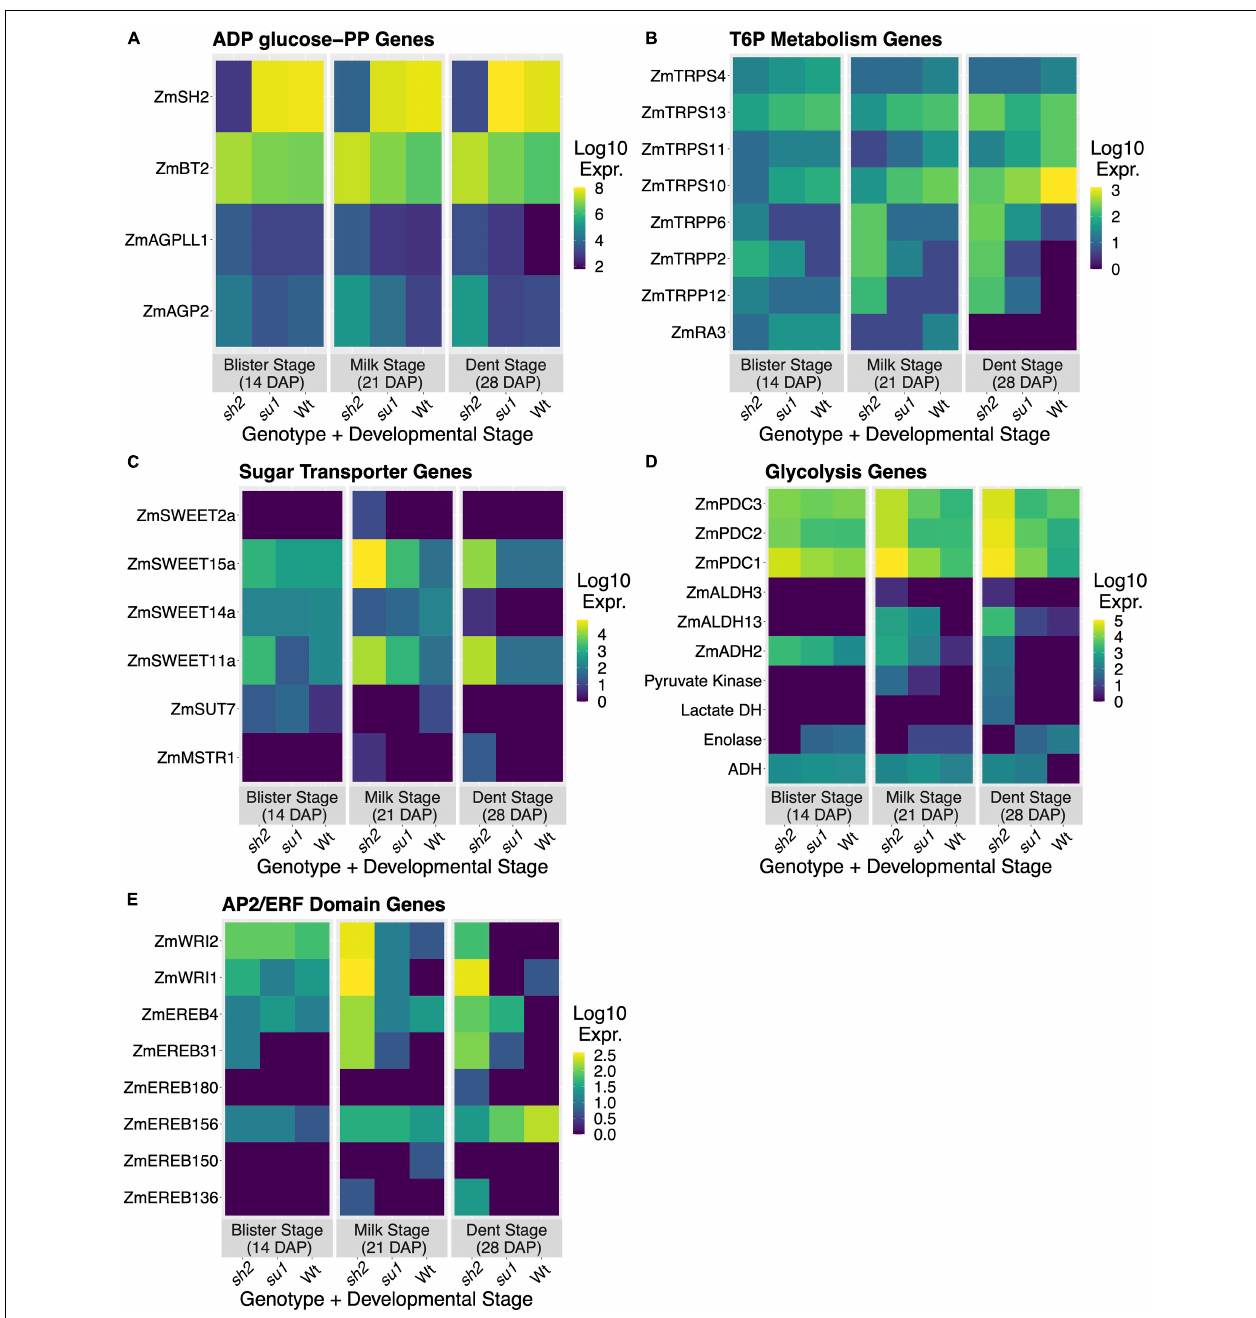
FIGURE 4 | Differential expression in maize endosperm. Relative expression levels of DEGs in each mutant/timepoint combination. Values shown represent the log 10 of the TPM summed across transcripts and averaged across backgrounds. (A) Relative expression of AGPase-encoding genes. (B) Relative expression of trehalose-6-phosphate metabolizing enzymes. (C) Relative expression of sugar-transporting genes. (D) Relative expression of genes encoding glycolytic enzymes. (E) Relative expression of AP2/ERF domain transcription factors.